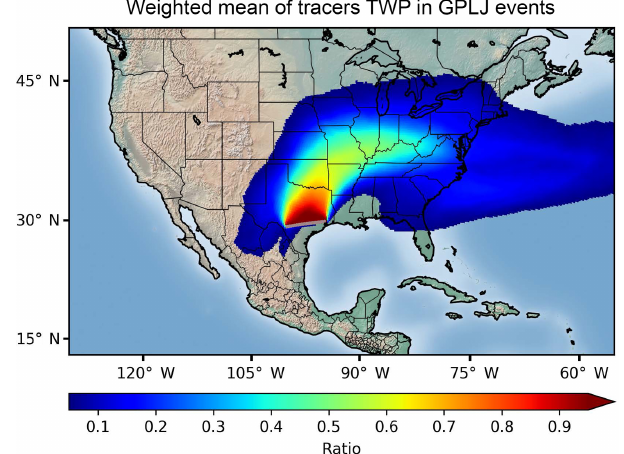
Figure 4. Statistically weighted ratio of precipitable water trans- ported by the GPLLJ for the five case studies with NLLJ>0 consid- ered in the analysis in Fig. 3. Weights applied are stated in Table